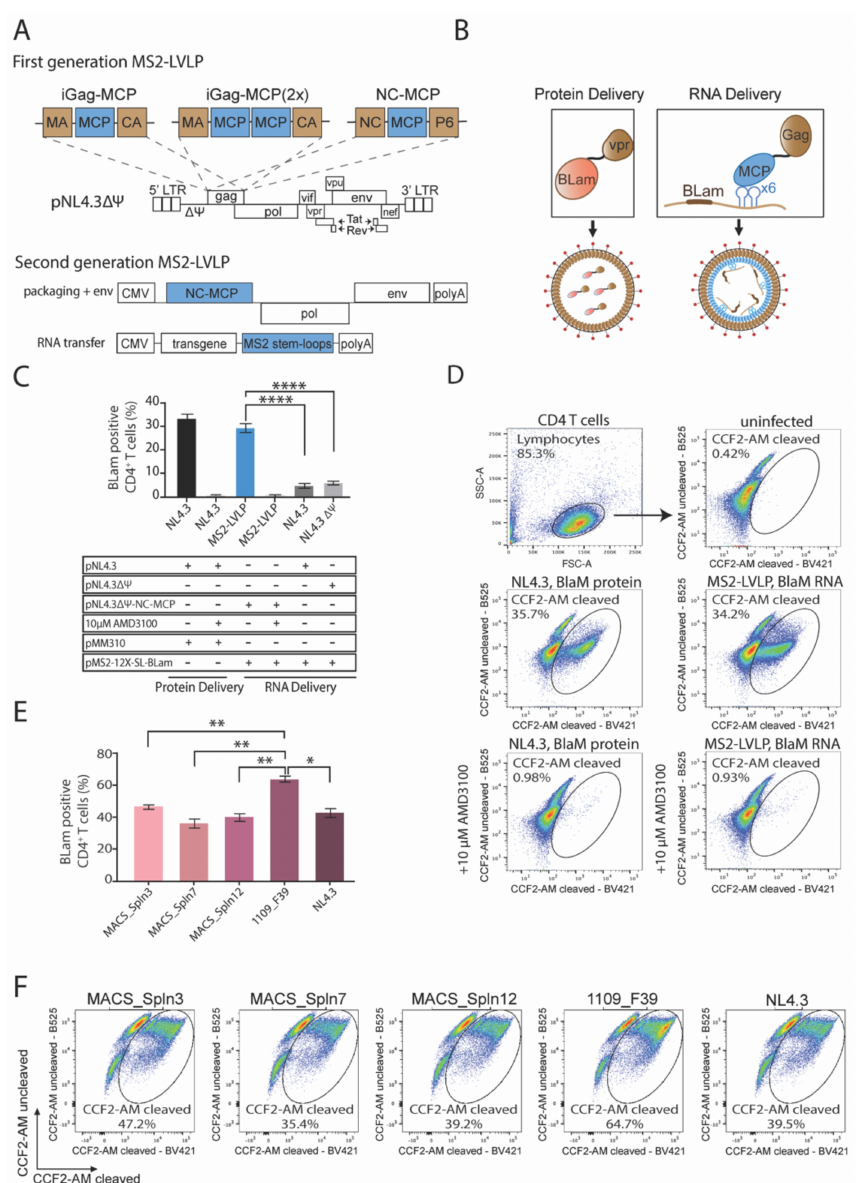
Figure 3. Efficient transient delivery of biologically active RNA to resting CD4 T cells using MS2- LVLPs optimized with highly fusogenic HIV envelopes. ( A ) Schematic illustration of generated first-generation and second-generation MS2-LVLPs. First-generation MS2-Gag polyprotein variants were constructed from a packaging incompetent HIV NL4.3 mutant ( ∆Ψ ). The MS2CP was either incorporated in between the matrix protein (p17) and capsid protein (p24) as monomer